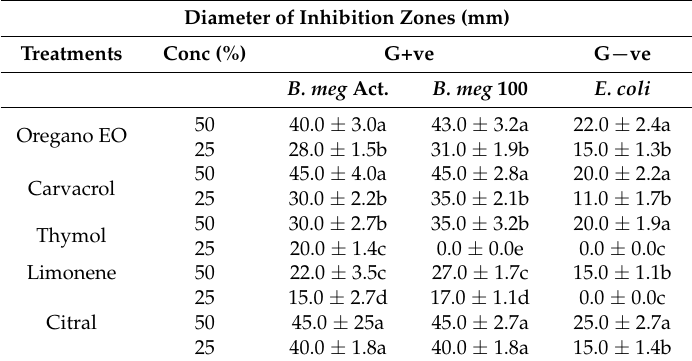
Table 4. Antibacterial activity of O. vulgare EO and its main active constituents.